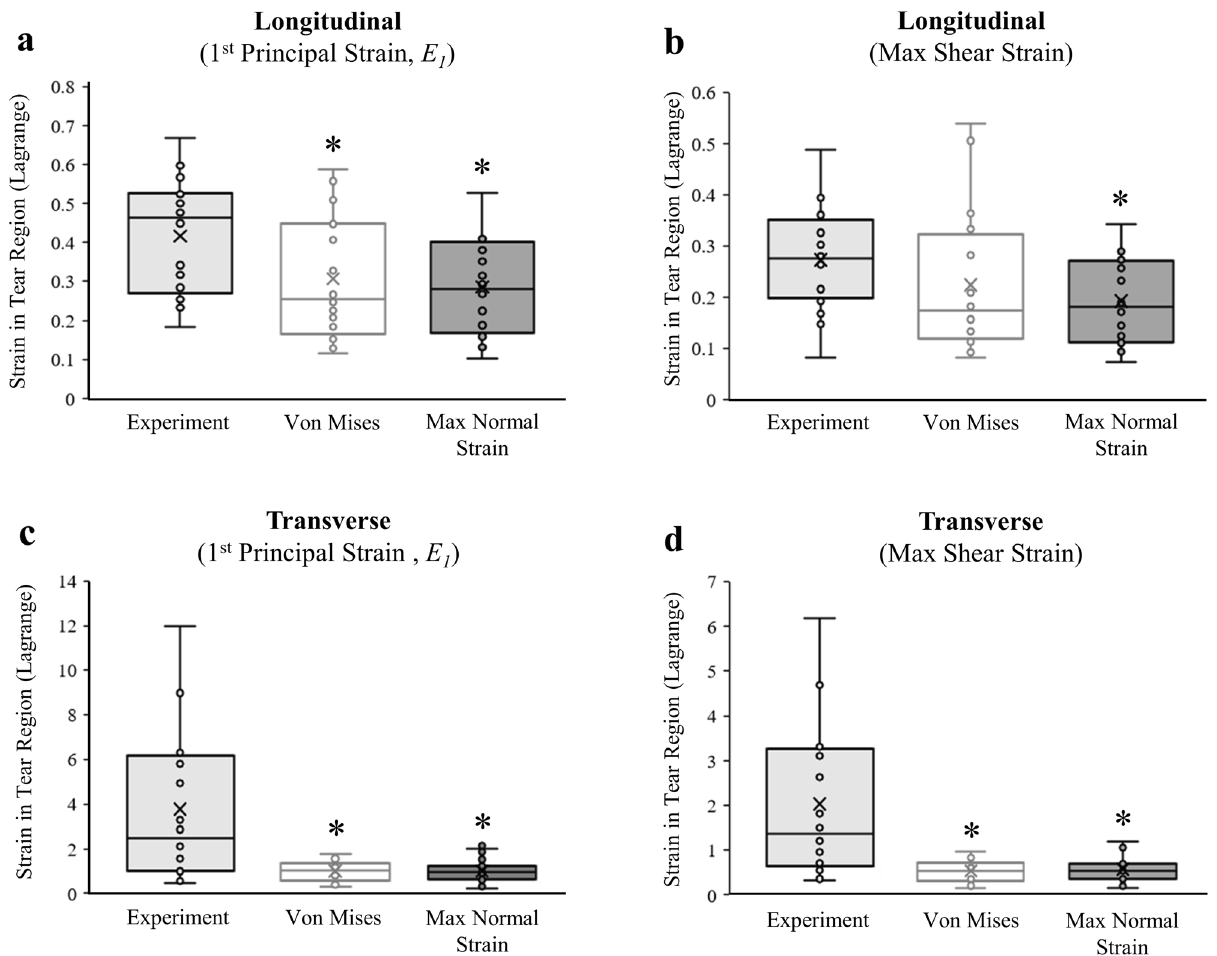
Figure 7. Comparison of principal strains in the tear region (ROI) between experiments measured using DIC and FE models generated with von Mises stress or maximum normal strain damage criterion. ( a ) Both damage criteria significantly under predicted the first principal strains for the longitudinal loading condition, but ( b ) only the maximum normal strain damage criterion significantly underpredicted the max shear strains. ( c ) When loading transverse to the fiber direction, both models significantly underpredicted first principal strains and ( d ) max shear strains. *Significantly less than experimentally measured strains ( p < 0.05). The ‘x’ in the box plot = average